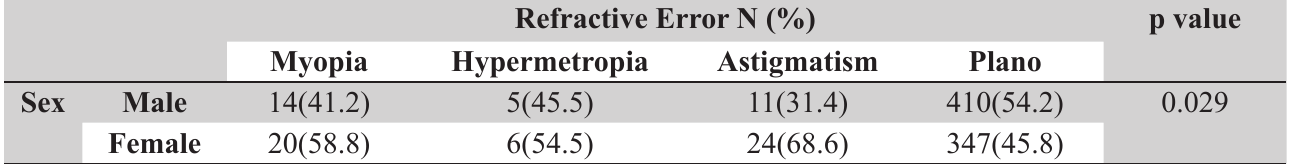
Table 4: Association of refractive error with sex of the children.